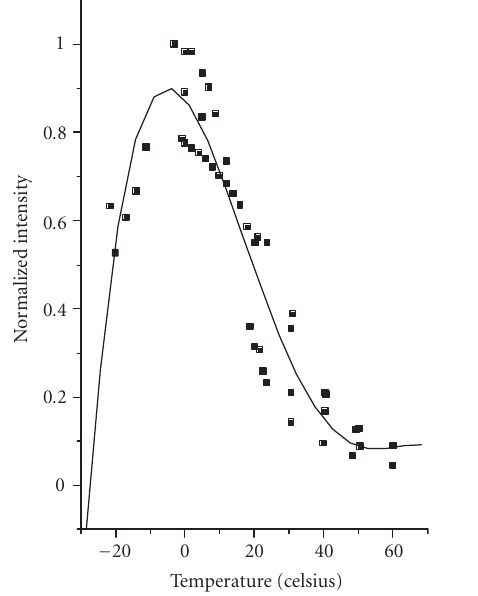
Figure 5: Temperature dependence of normalized YQD PL in toluene as a function of temperature. Data have been collected from several measurements on samples with and without titration with (m − Pyr) 4 H 2 P. Temperature cycles are subject to irreversible PL losses. The line is merely a guideline for the eye.